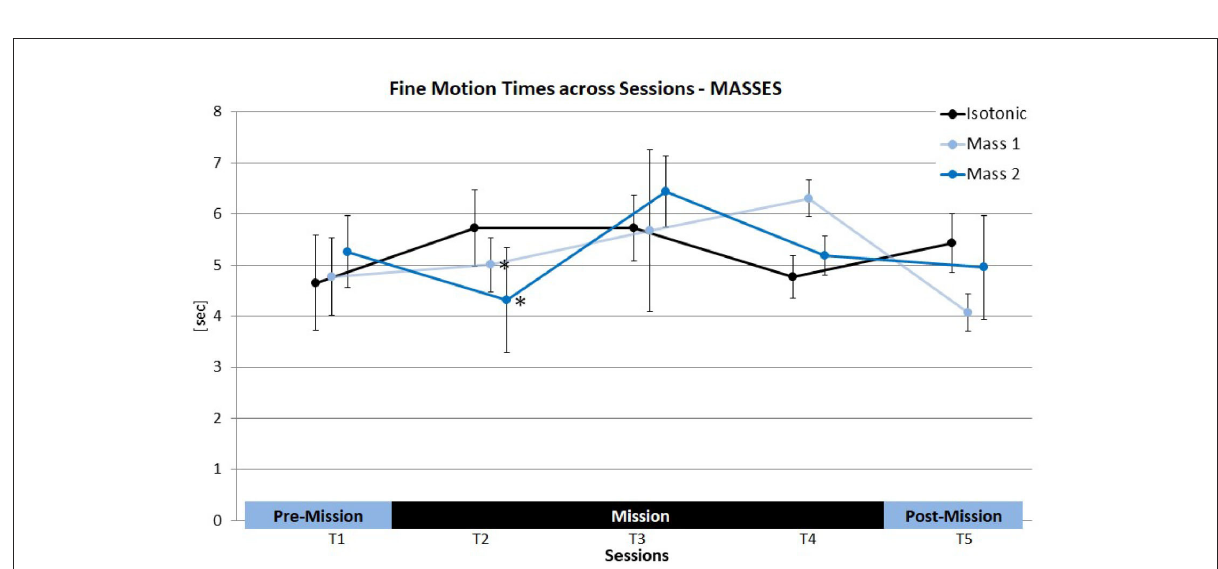
FIGURE5 Overview of stiffness effects on fine motion times (FMT) compared to the isotonic baseline condition (black line) across sessions (means ± SE). * p <